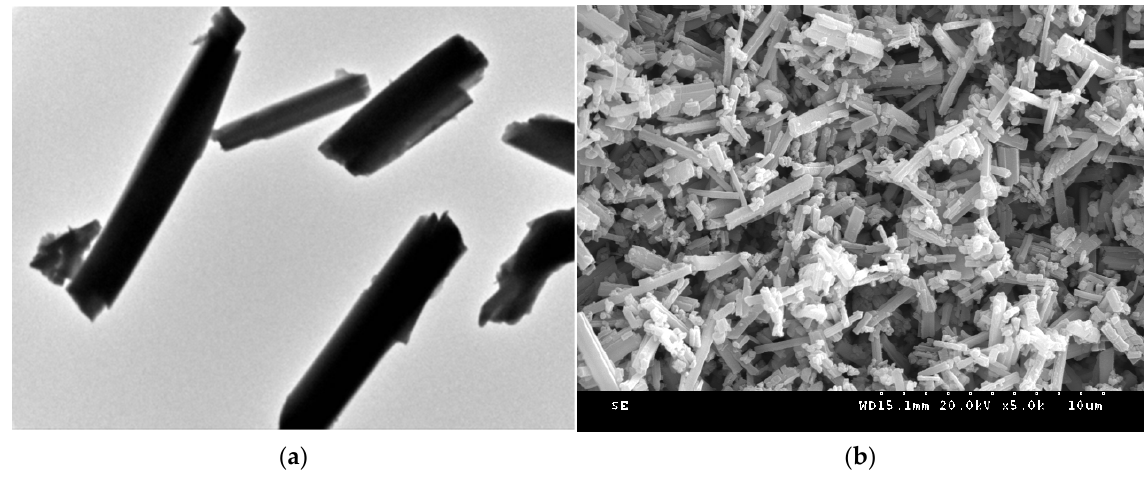
Figure 5. ( a ) TEM and ( b ) SEM of Eu 0.075 Tb 0.925 -MOF.